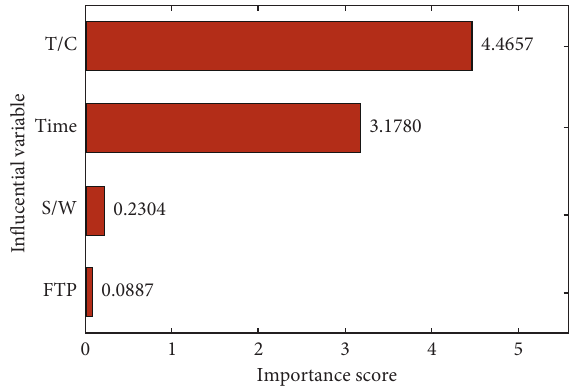
Figure 7: Variable importance of CPB based on the